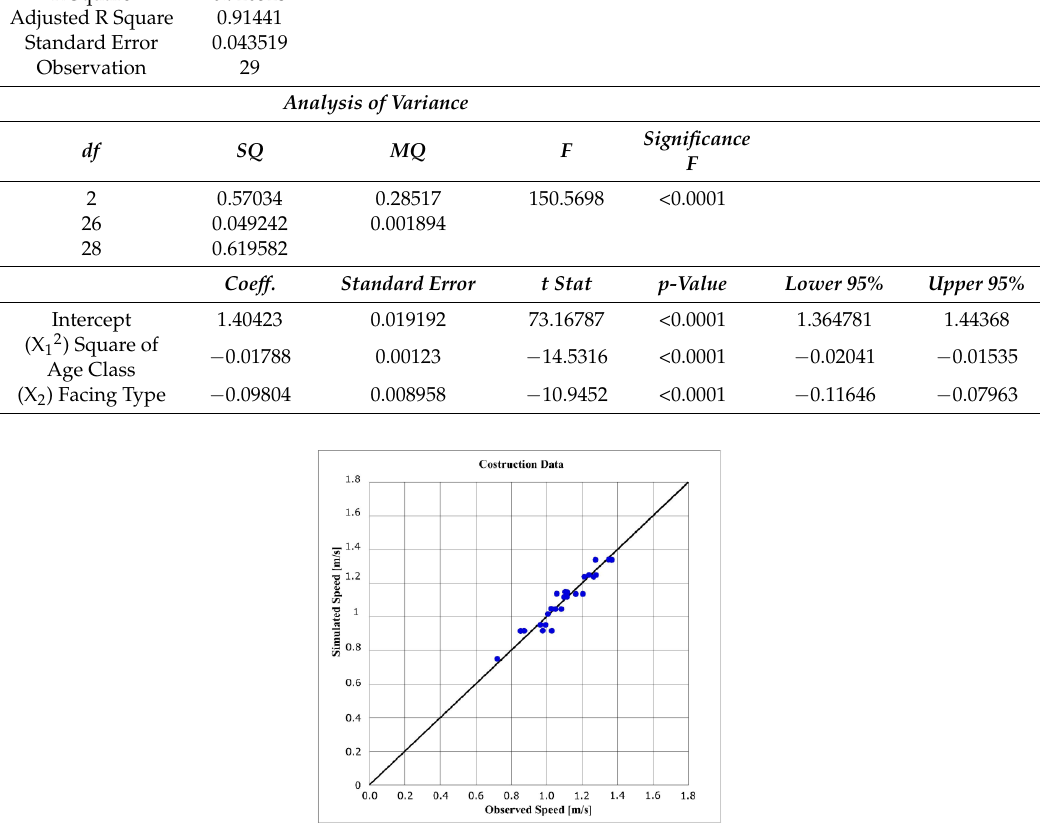
Table 6. Global model: regression statistics and ANOVA.